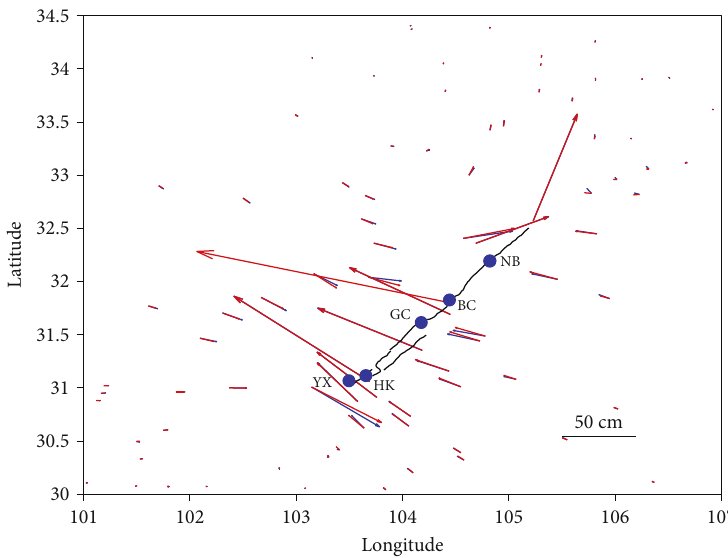
Figure 3: Comparison between observed GPS data (blue curves) and synthetic data (red curves).